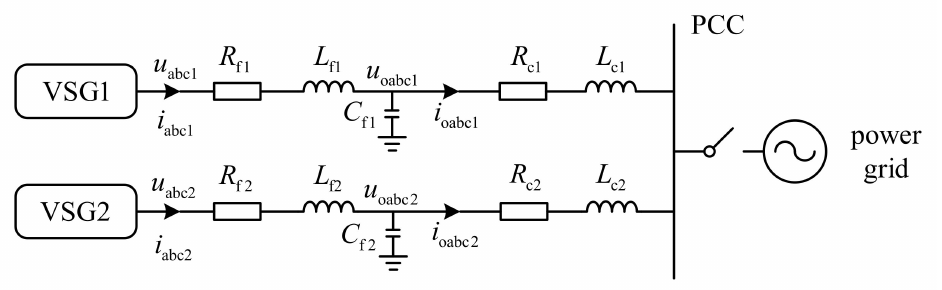
Figure 9. Structure diagram of a two-VSG system.